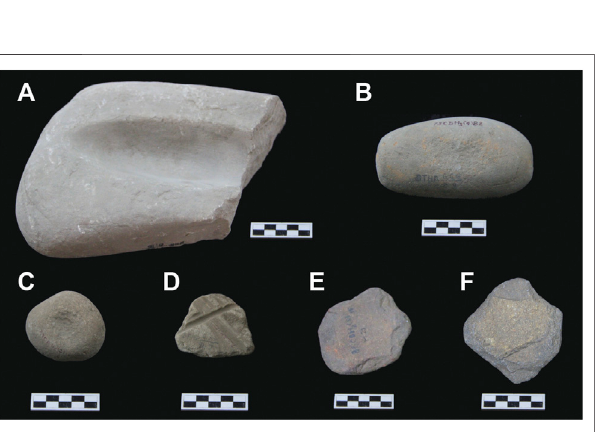
FIGURE 2 | Trench pro fi le of south wall of H3, Cai Beo site (1973 excavation, after Nguyen, 2009: 62).